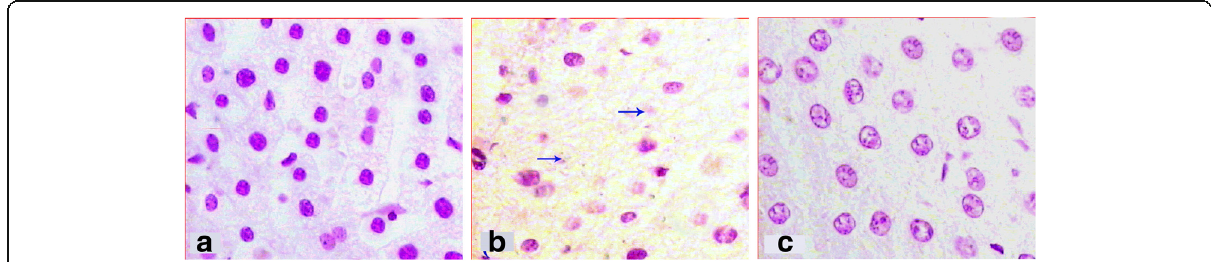
Fig. 2 a Section in control rat showing normal content of DNA in nuclei of hepatocytes. b CP-treated rat showing marked reduction of DNA content in nuclei of hepatocytes with decreasing number of nuclei (arrows). c Sections in rat treated with ABG + CP showing marked improvement of DNA content with increasing number of nuclei (Feulgen histochemical stain,